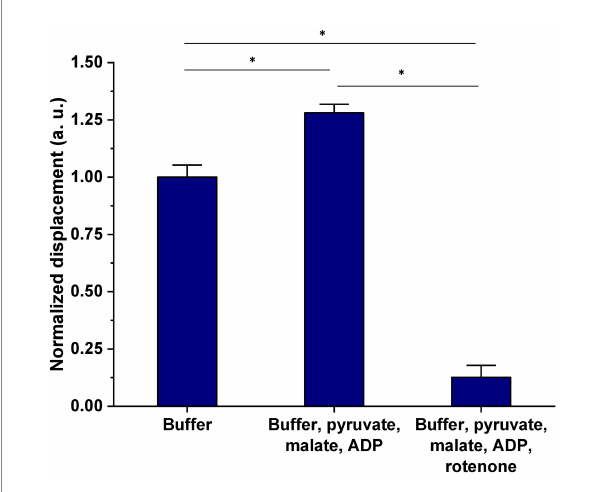
FIGURE 5 Effect of 15 min exposure of mitochondria isolated from HEK293T cells, to pyruvate, malate, and ADP on mitochondrial nanomotion as compared to control and “dead” (rotenone treated) organelles. Results are presented as mean ± SEM and are representative of three independent experiments. The number of mitochondria analyzed in each treatment was as follows: buffer = 237, buffer + 5 mM pyruvate + 5 mM malate + 1 mM ADP = 339, buffer + 5 mM pyruvate + 5 mM